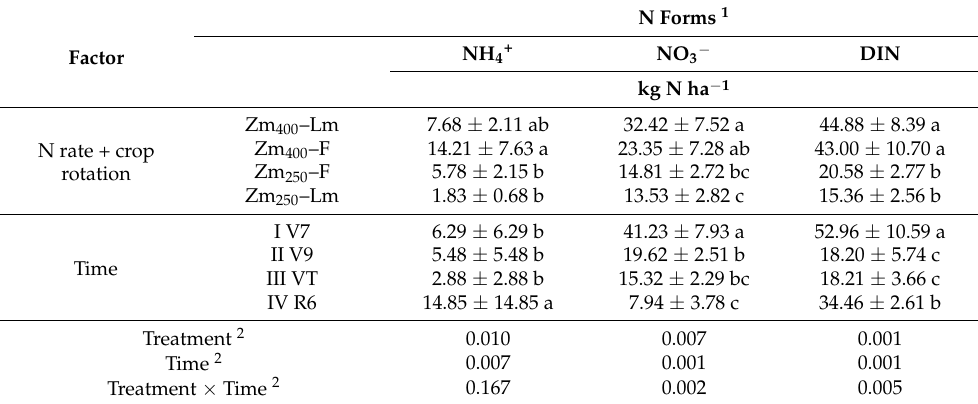
Table 7. Amount of ammonium (NH 4+ ), nitrate (NO 3 − ), and dissolved inorganic N present in leachate during the maize crop